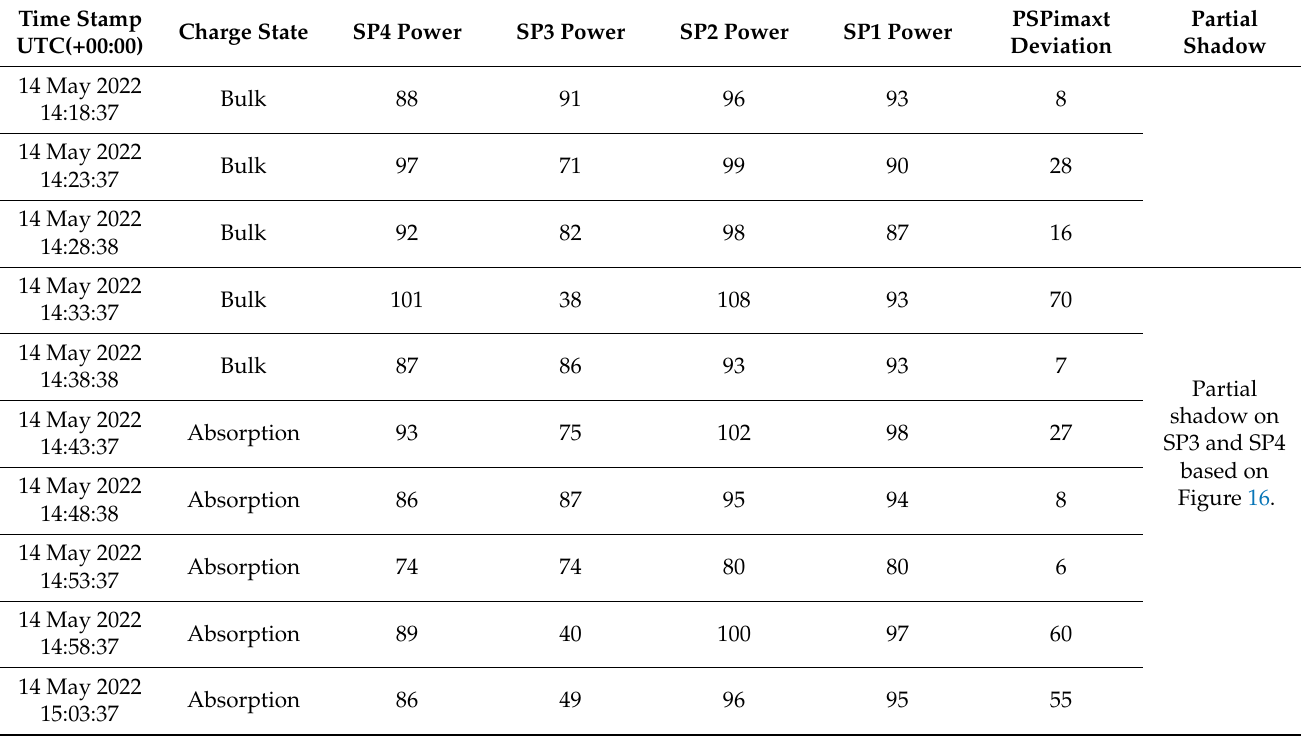
Table A3. SP quantitative power values and deviation registered the 14 May 2022 from 15:08:37